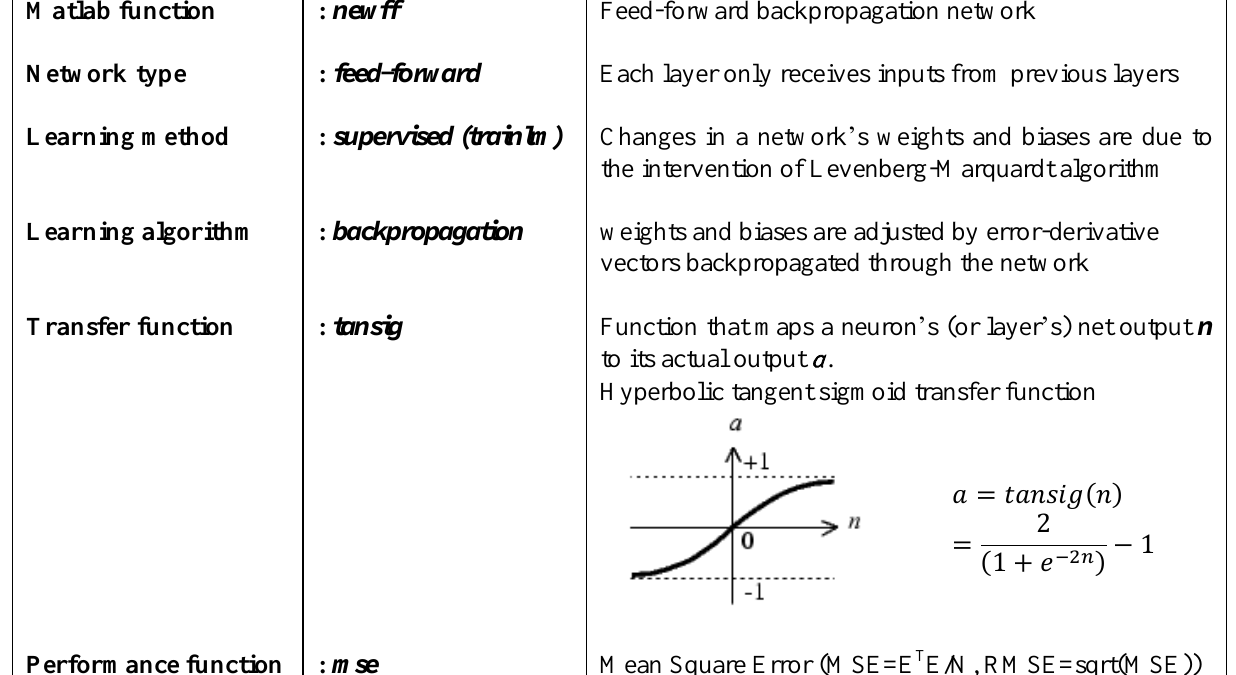
Table 3. Summary of the adopted parameters in the NN prediction of the sea-level time series. Matlab